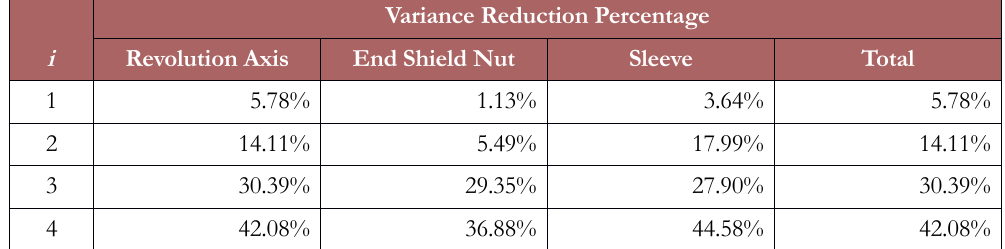
Table 29. Effects of learning cycles to varianvce